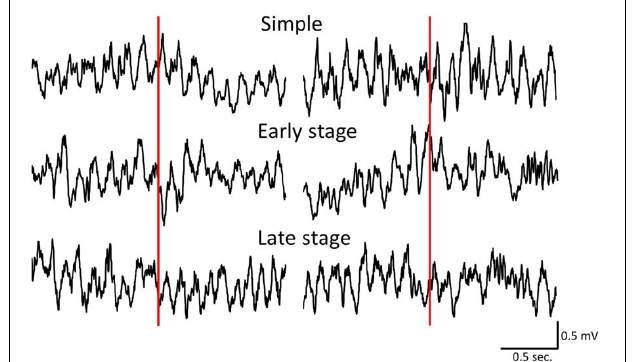
FIGURE 3 | Sample of hippocampal EEG wave during simple discrimination task (Simple), early learning stage (Early stage), and late learning stage (Late stage). Left panels indicated the sample of hippocampal EEG during RFT and Right panels indicated the sample of hippocampal EEG during non-RFT. Red line was at the point of stimulus